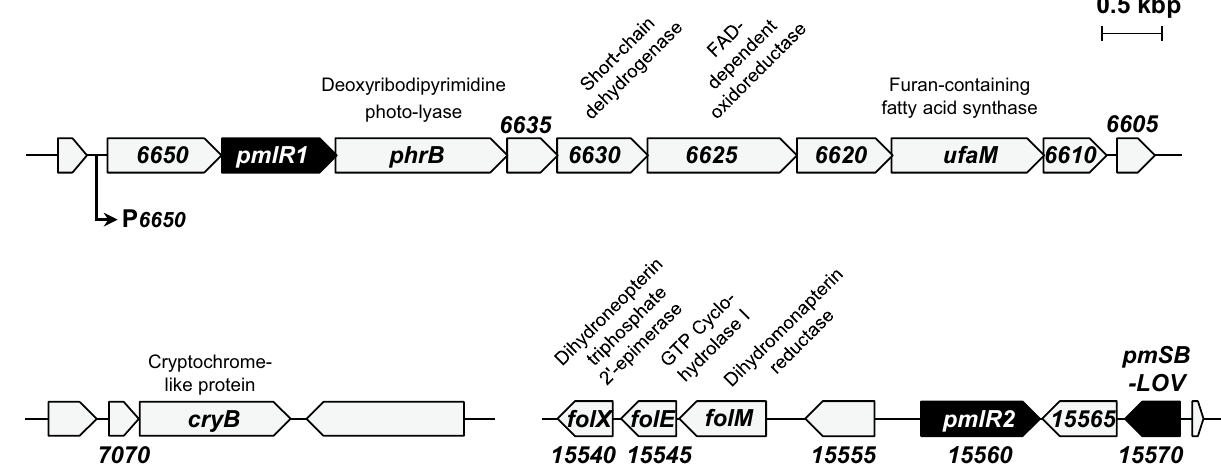
Figure 1. Gene organization of the pmlR1 and PmlR2 genomic regions. P 6650 is a light-inducible promoter analyzed in this study. The homologous genes with known functions include phrB , a deoxyribodipyrimidine photo-lyase; PME6630 , a short-chain dehydrogenase; PME6625 , a FAD-dependent oxidoreductase; ufaM , a furan-containing fatty acid synthase; cryB , a cryptochrome/photolyase family protein; folX , a dihydroneopterin triphosphate 2 ′ -epimerase; folE , a GTP cyclohydrolase I; and folM , a dihydromonapterin reductase. Other ORFs encode proteins without annotated/known function.